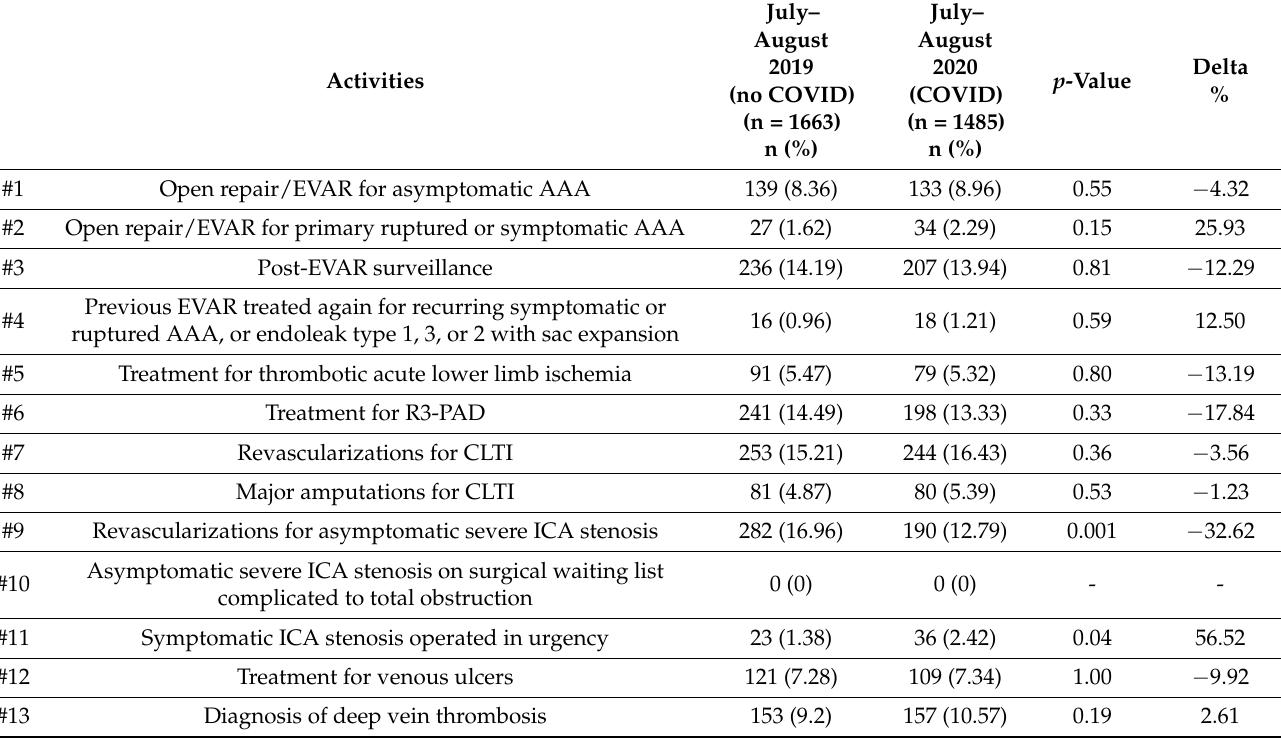
Table 5. Summary of the responses to the questionnaire for the COVID-19 months of July–August